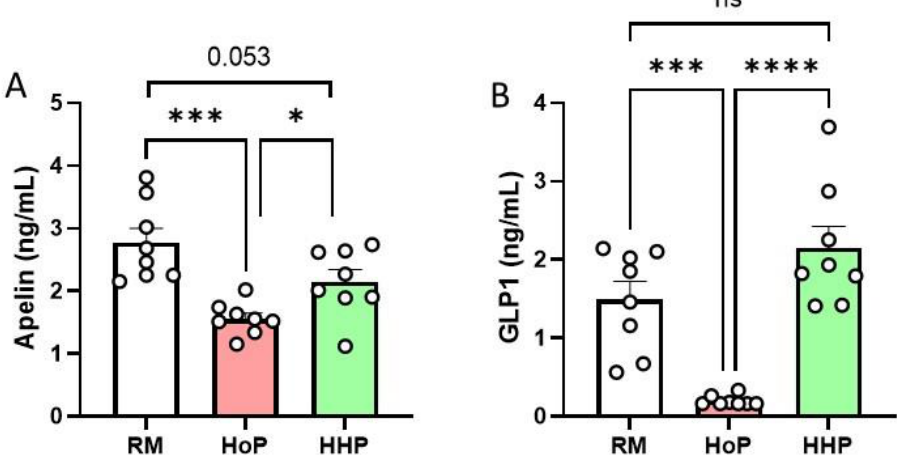
Figure 1. Concentrations of apelin ( A ) and GLP-1 ( B ) in raw human milk (RM) and after Holder pasteurization (HoP) and high hydrostatic pressure (HHP) processing of BM. Data are presented as mean ± SEM. Asterisks correspond to level of statistical significance: * p < 0.05; *** p < 0.001; **** p < 0.0001.